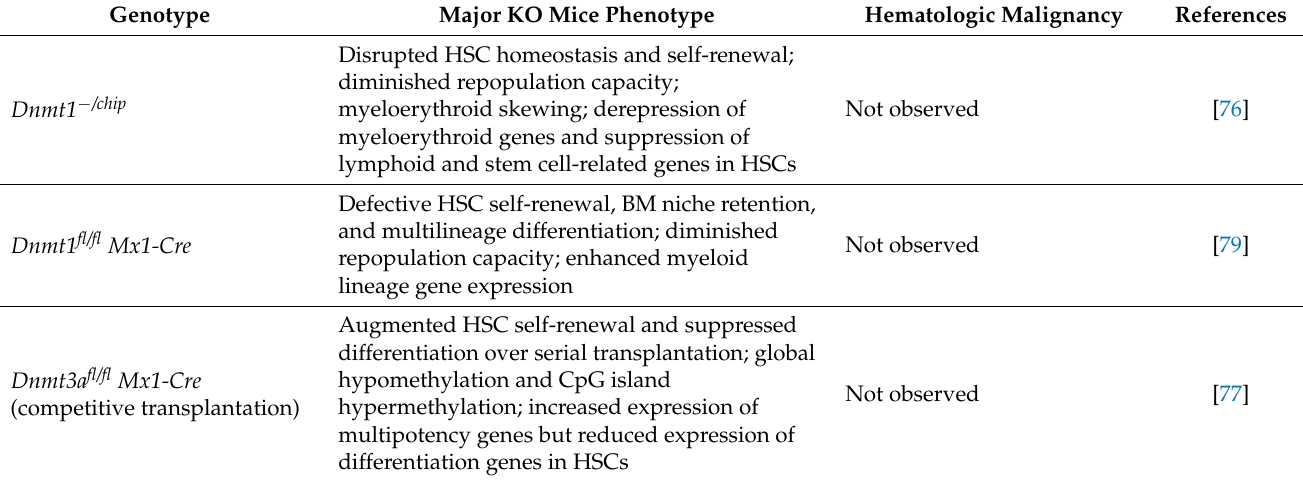
Table 1. Hematopoietic phenotypes of DNMT-deficient animal models.